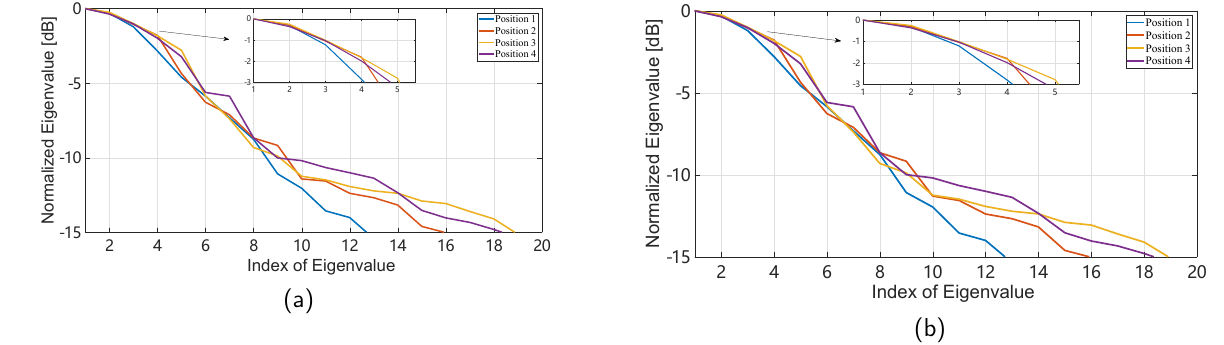
Figure 13. The normalized eigenvalues versus eigenvalue index obtained in frequency and spatial domains at 4 user locations. ( a ) The normalized eigenvalues versus eigenvalue index in frequency domain. ( b ) The normalized eigenvalues versus eigenvalue index in spatial domain.